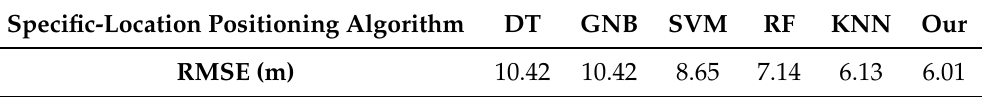
Table 5. Specific-location positioning